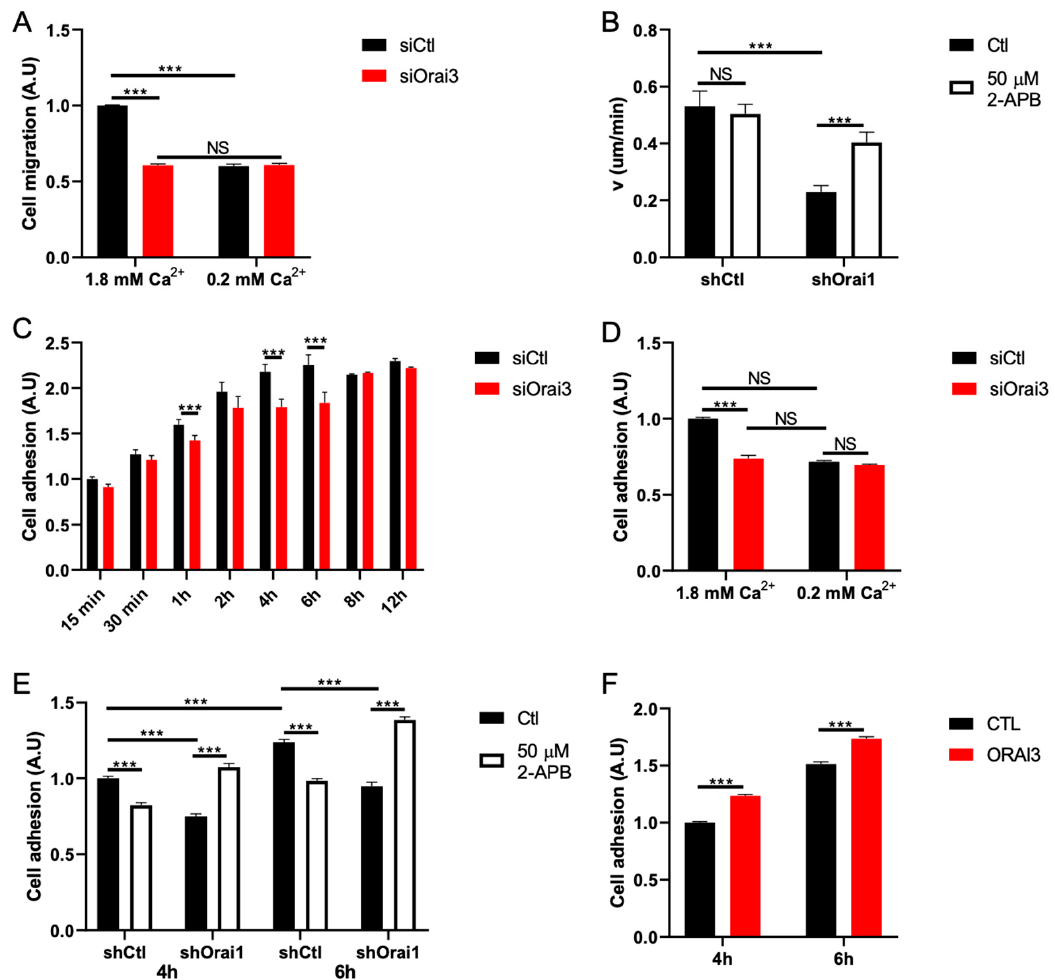
Figure 3. Orai3 regulates cell migration and adhesion in a Ca 2+ -dependent manner. ( A , B ). Orai3-mediated Ca 2+ entry supports cell migration. Migration assay using Boyden chambers in the presence or absence of Ca 2+ ( A ) (N = 3; *** p < 0.001; NS Non-Significant) and cell migration speed following Orai3 activation with 2-APB, evaluated by live-cell imaging ( B ) (shCtl Ctl n = 39; shCtl 2-APB n = 41; shOrai1 Ctl n = 42; shOrai1 2-APB n = 39; N = 3; *** p < 0.001; NS Non-Significant). ( C ). Orai3 activity regulates cell adhesion. Cell adhesion assay using an MTT-based technique (N = 3; *** p < 0.001). ( D , E ). Cell adhesion is mediated by Ca 2+ entry through Orai3. MTT-based cell adhesion assay in the presence or absence of Ca 2+ ( D ) and following Orai3 activation with 2-APB ( E ) (N = 3; *** p < 0.001; NS Non-Significant). ( F ). MTT-based cell adhesion assay showing that Orai3 overexpression enhances cell adhesion (N = 3; *** p < 0.001; NS